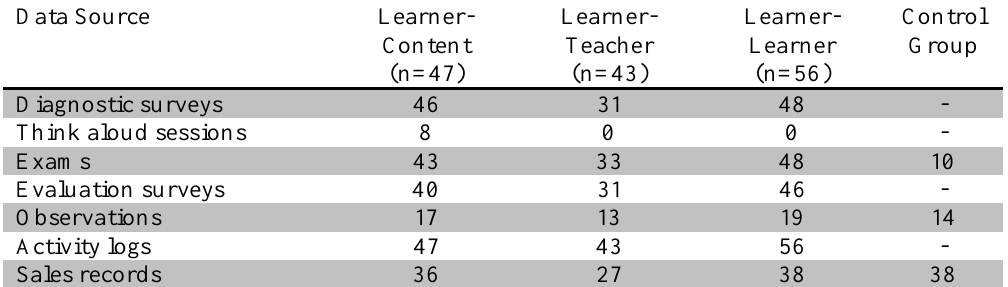
Table 2 Participants per Data Source Data